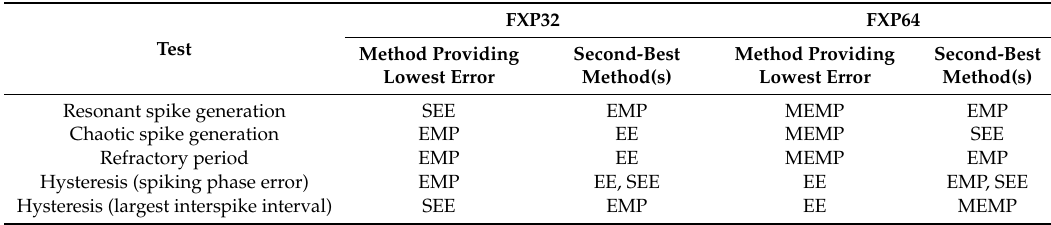
Table 6. Table summarizing the results of the